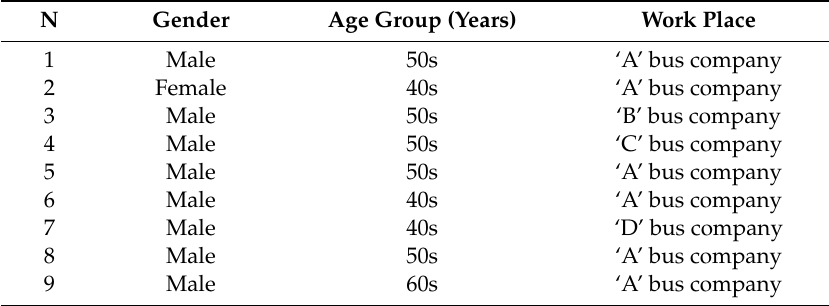
Table 1. Characteristics of the participants.